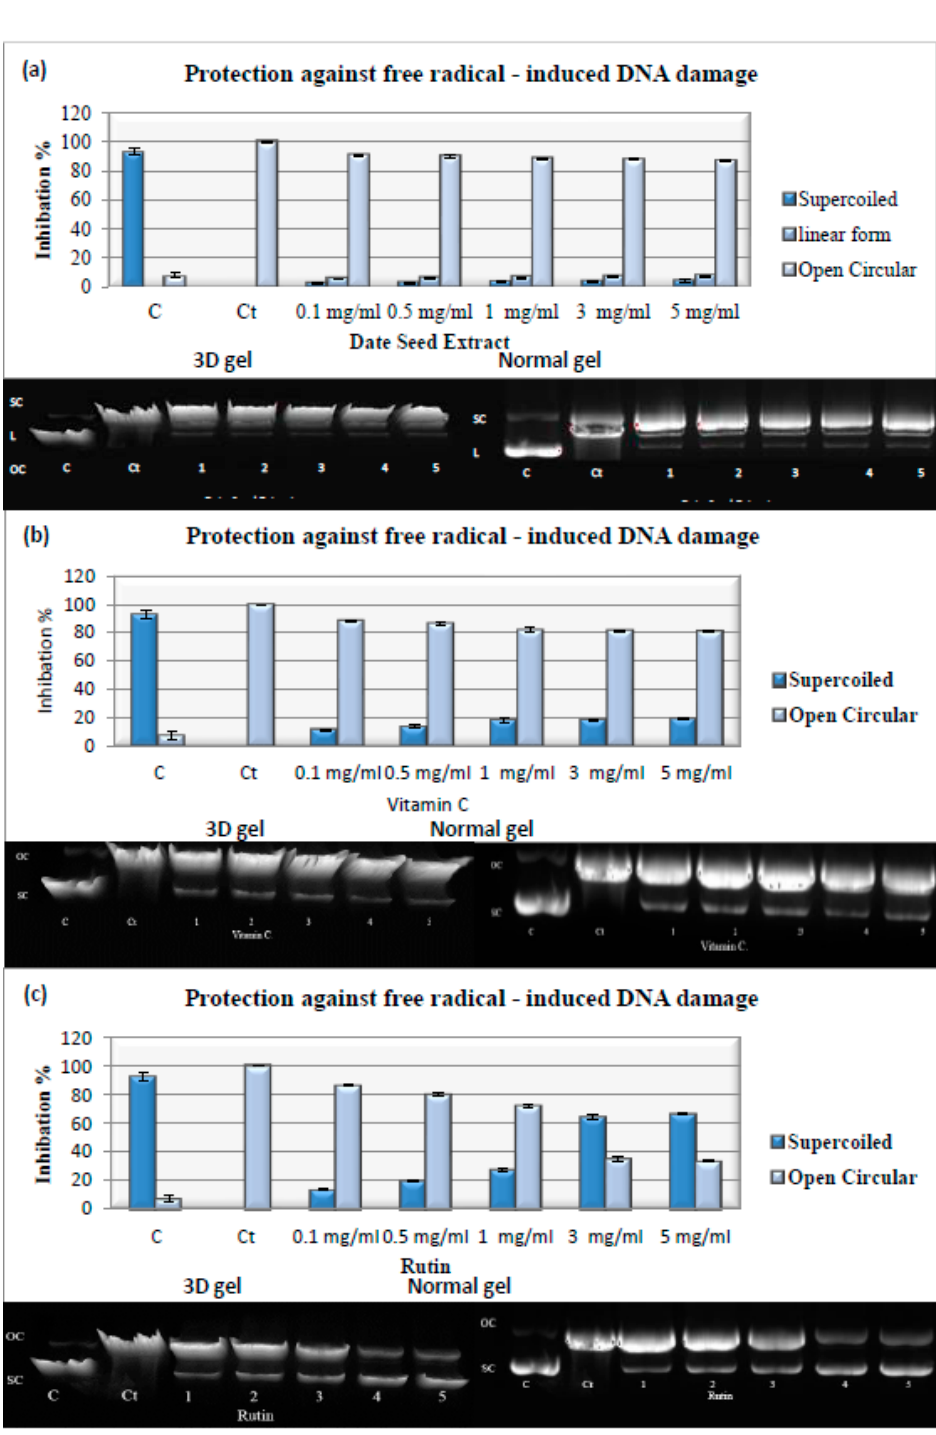
Figure 3. Normal gel, 3D gel, and densitometric analysis for ( a ) DSE, ( b ) V.C., and ( c ) rutin at dif- ferent concentrations. C: Plasmid, Ct.: plasmid + H 2 O 2 + UV, Lanes 1–5: plasmid + DSE, V.C., or rutin at 0.1–5 mg/mL + H 2 O 2 + UV. C and Ct are cropped from different parts of the same gel. Data are expressed as the mean ± SD; n = 3.